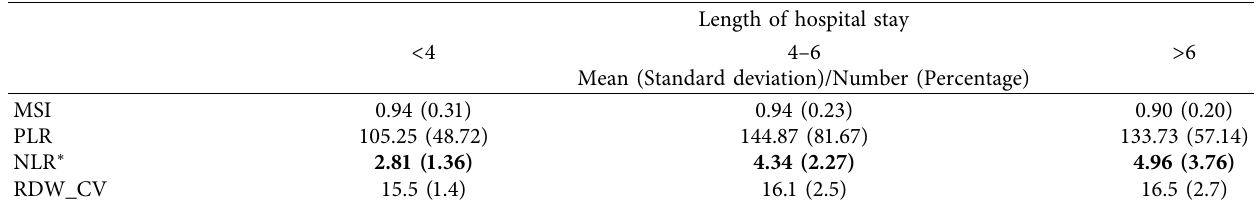
Table 8: Mean ± SD of neutrophil to lymphocyte ratio (NLR), platelets to lymphocyte ratio (PLR), modifed shock index (MSI), and red cell distribution width (RDW) among the tertile of hospitalization time in patients with HFpEF and HFmrEF. ∗ signifcant between group diference.